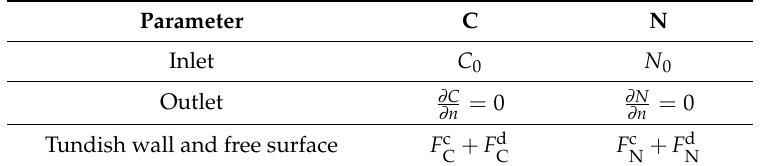
Table 2. Boundary conditions of inclusion [25,26].